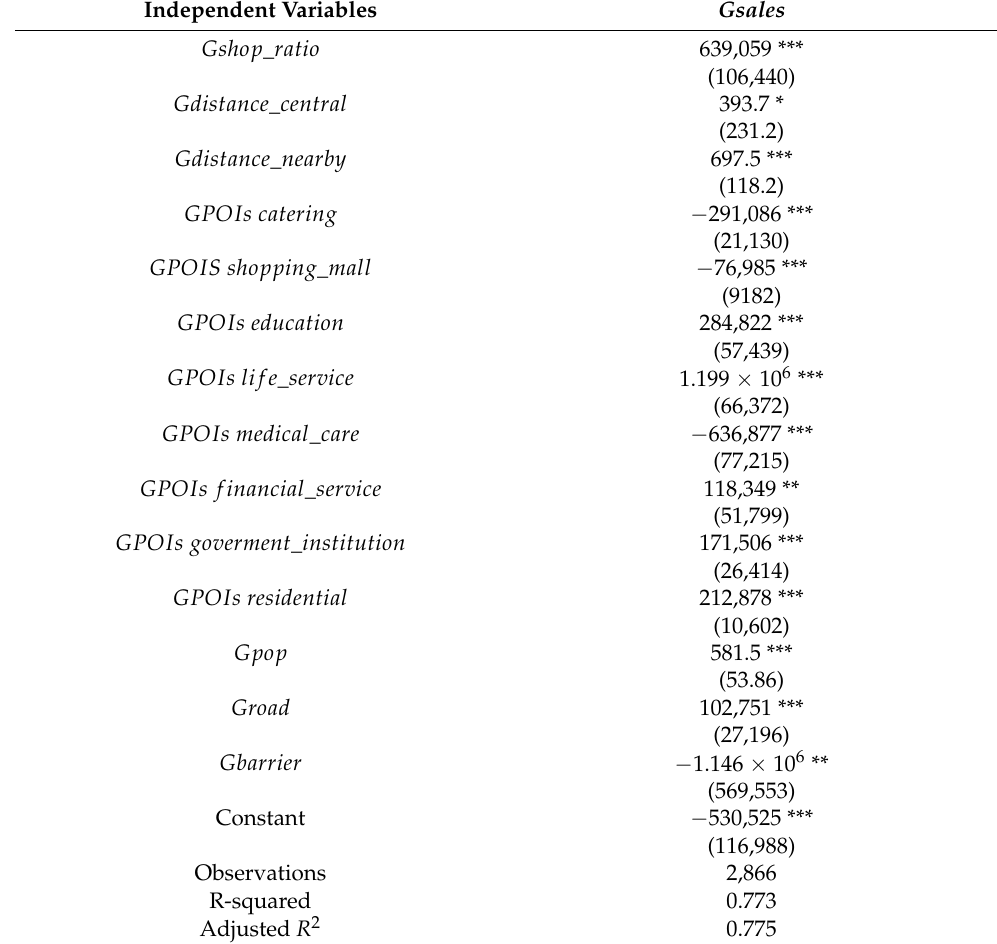
Table 4. Regression results of the effects of distance metrics on sales